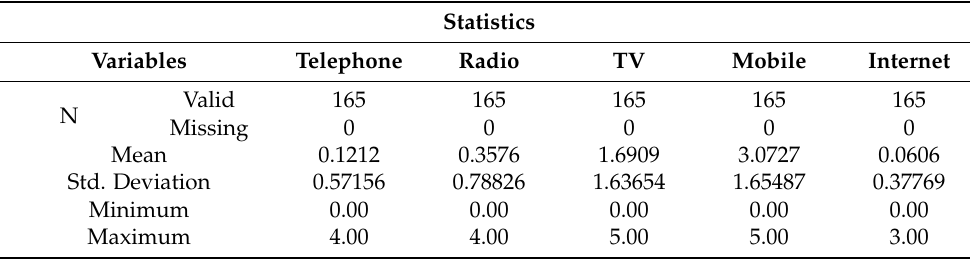
Table A2. Mean, std. deviation, minimum and maximum of electronic media usefulness for dairy